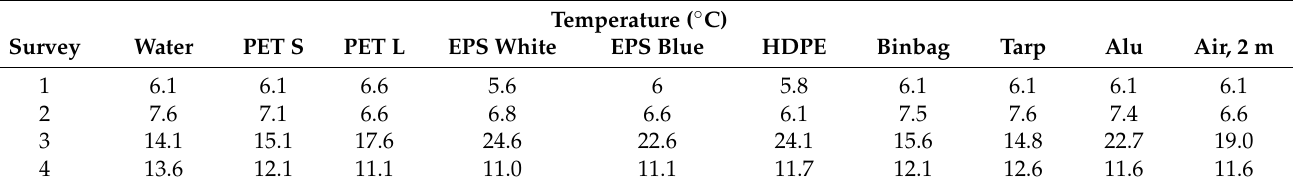
Table 5. Target surface, water, and air temperatures during the FLIR recording minute, using the iButton dataloggers (1-min averaged over 0.1 Hz